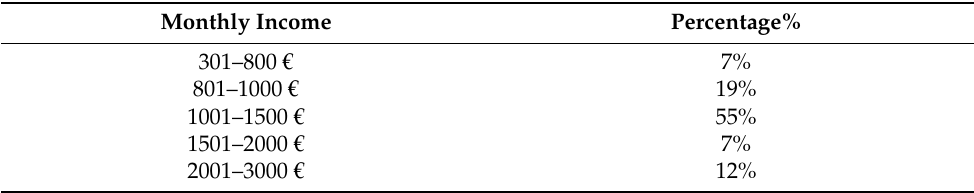
Table 7. Monthly Income.